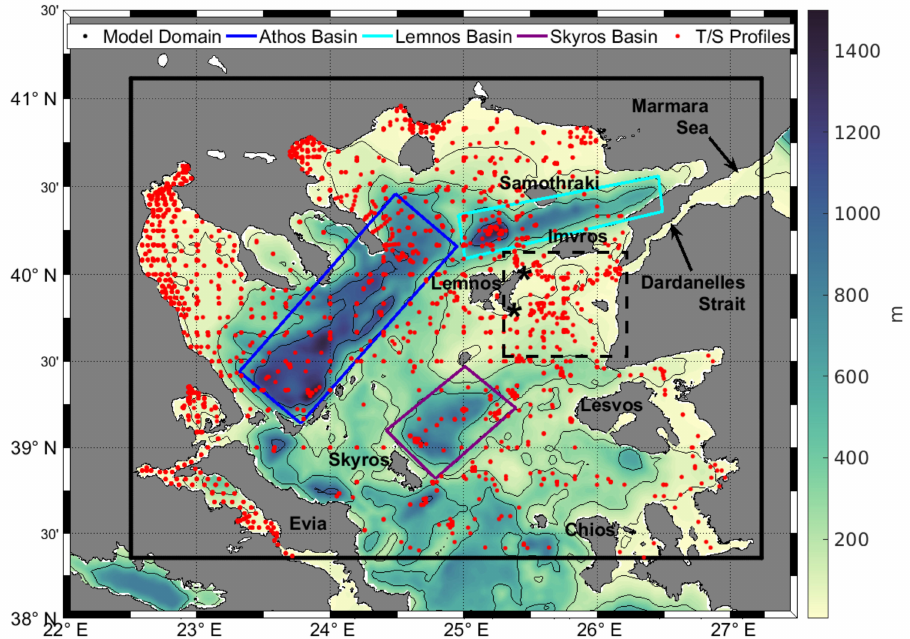
Figure 1. Map of the North Aegean Sea. The model’s computational grid is defined by the black rectangle. The blue rectangle identifies the Athos deep basin, the green the Skyros basin and cyan the Lemnos basin. The red dots are T/S profiles from R/Vs for the period from 1986 to 2013. Dash black line denotes the area of Dardanelles Strait exit. The star symbols (*) identify the locations of the HF radar antenna